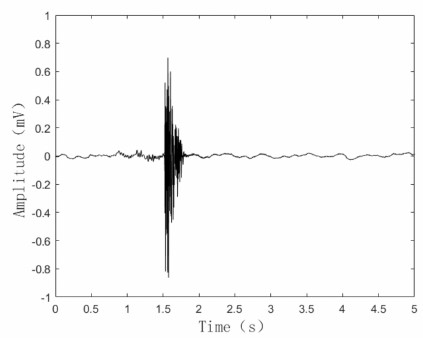
Figure 2. Measured signal received by VLA at 9.8